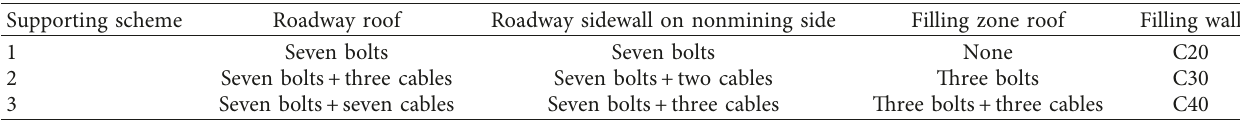
Figure 8: Schematic diagram for the location of the drainage boreholes in the 2D model. Coordinates attached on the right section indicate initial location and final location for each drilling path. Table 3: Three different support schemes.